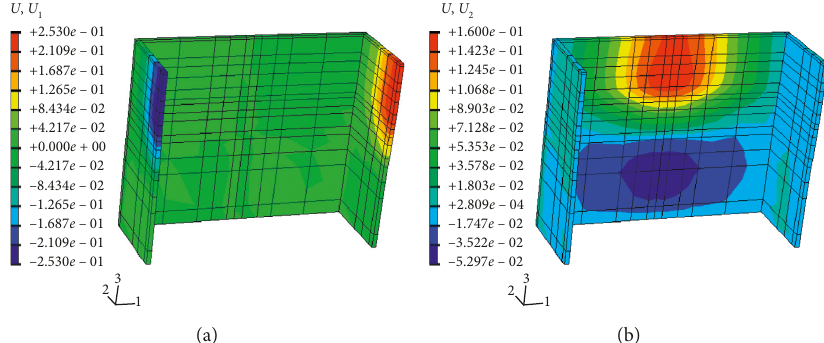
Figure 7: (a) The horizontal displacement cloud pictures of diaphragm wall. (b) The vertical displacement cloud pictures of diaphragm